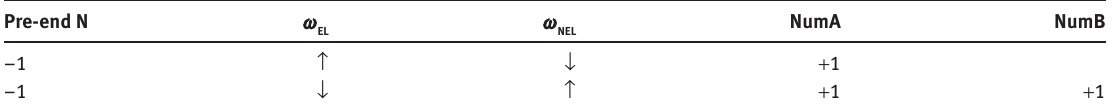
Table 4: Weight Alteration for NIL. Pre-end N